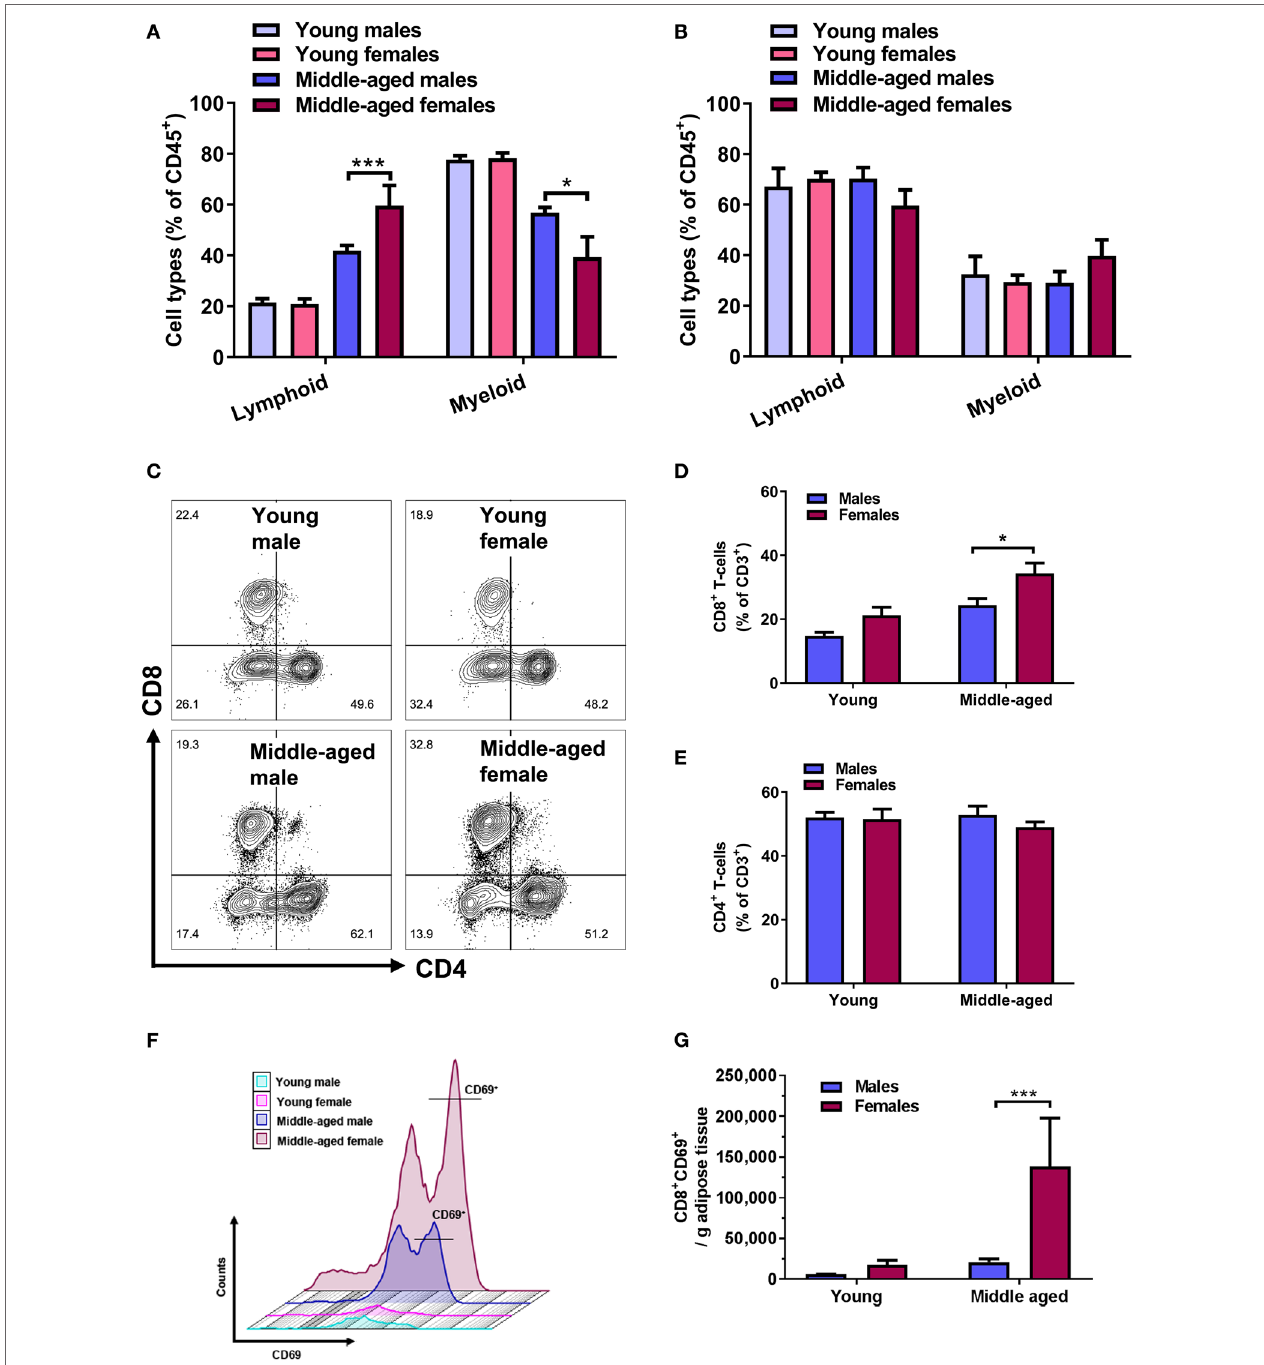
FigUre 2 | Age-associated increases in adipose lymphoid cells and CD8 + T cells are pronounced in females. Flow cytometry quantification of lymphoid (CD45 + CD11b − ) and myeloid cell (CD45 + CD11b + ) percentages of (a) adipose tissue and (B) blood-derived immune cells. Two-way ANOVA lymphoid cells: effect of age p < 0.001, effect of sex p < 0.01; myeloid cells: effect of age p < 0.001, * p < 0.05, *** p < 0.001 Sidak’s multiple comparison’s test, n = 5. (c) Representative contour plots of CD4 + and CD8 + T-cell populations, with outliers displayed, in adipose tissue of young and middle-aged male and female mice. (D) Quantification of CD8 + T-cell percentages (CD3 + CD8 + ) and (e) CD4 + T cells (CD3 + CD4 + ) in adipose tissue of young and middle-aged mice using flow cytometry. Two-way ANOVA effect of age: p < 0.001, sex: p < 0.01. * p < 0.05 Sidak’s multiple comparison’s test, n = 8–9. (F) Representative histograms of CD8 + CD69 + T cells in adipose tissue from young and middle-aged male and female mice. (g) Absolute number of activated CD8 + T cells (CD8 + CD69 + ) normalized to bead counts and adipose tissue weights. Two-way ANOVA effect of age: p < 0.05, sex: p < 0.05, *** p < 0.001 Sidak’s multiple comparison’s test, n = 5.